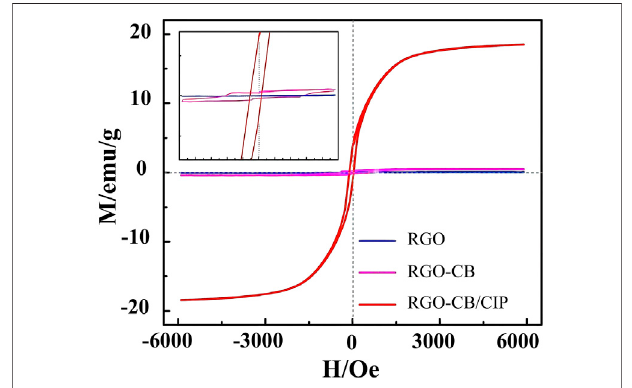
FIGURE 5 | The saturation hysteresis loop of the as-prepared samples.